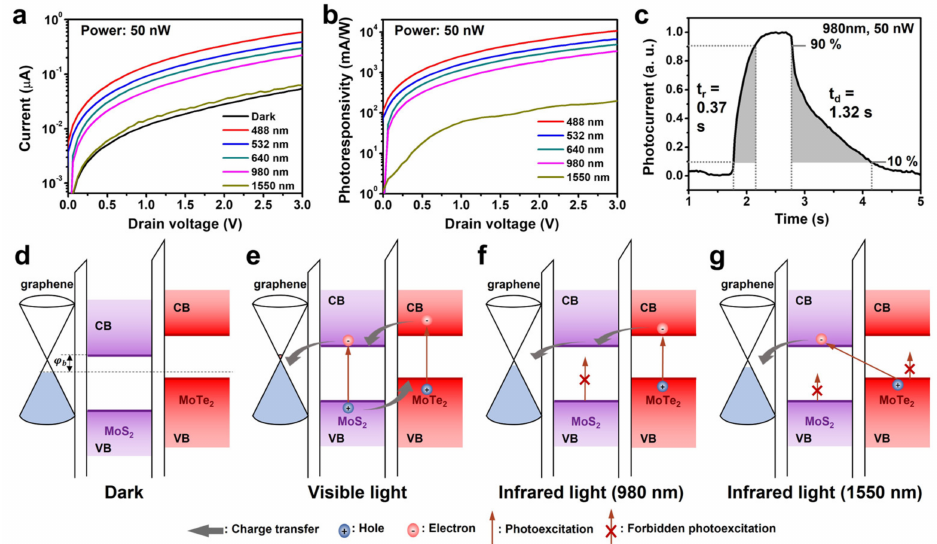
Figure 4. ( a ), Current-voltage curves of photodetector under illumination with 50 nW laser and ( b ), corresponding photoresponsivity-voltage curves. ( c ), Time-resolved photocurrent of device under illumination with 50 nW laser at 980 nm. ( d ), Energy band diagram and charge-transfer processes in dark and under illumination with ( e ), visible laser, ( f ), infrared laser at 980 nm, and ( g ), infrared laser at 1550